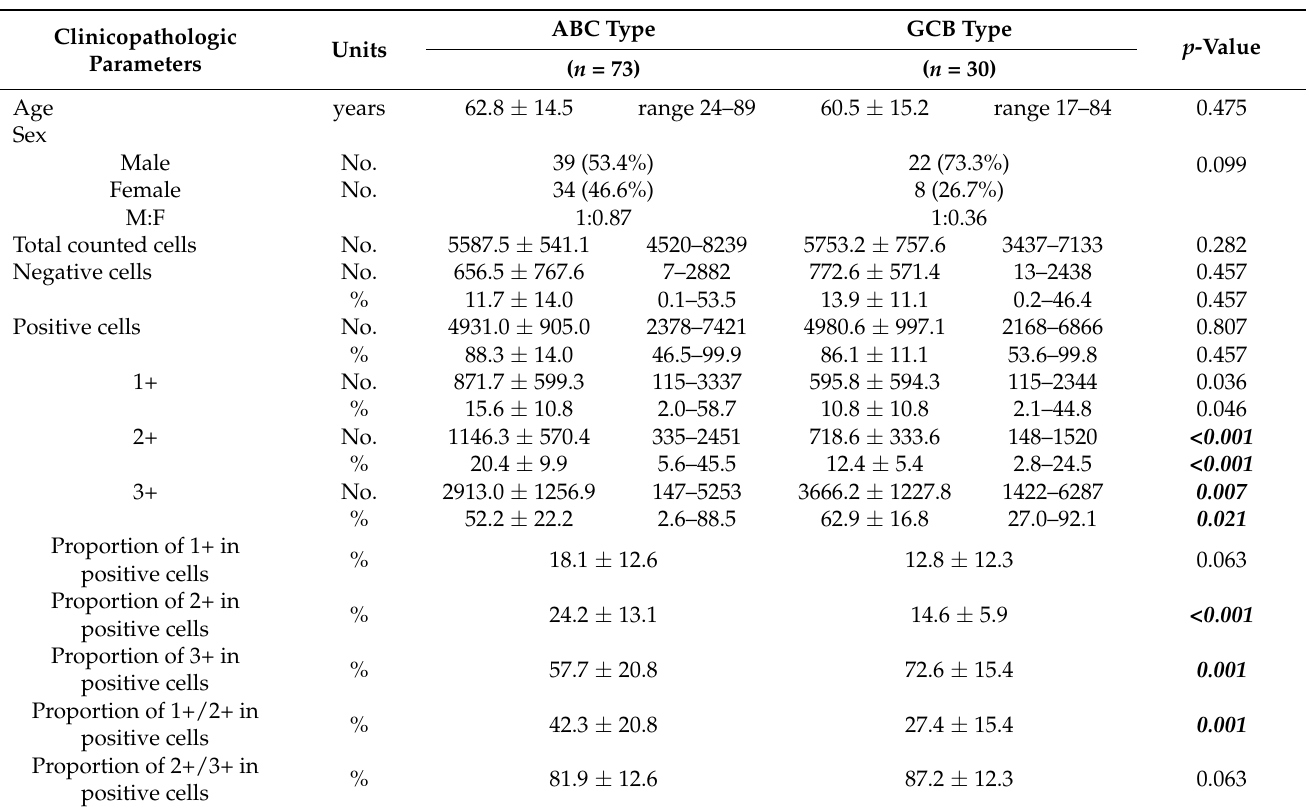
Table 2. Comparison of Ki-67 labeling index patterns between activated B-cell (ABC) and germinal center cell (GCB) subtypes of diffuse large B-cell lymphomas (DLBCLs). Significant p -values are bolded and